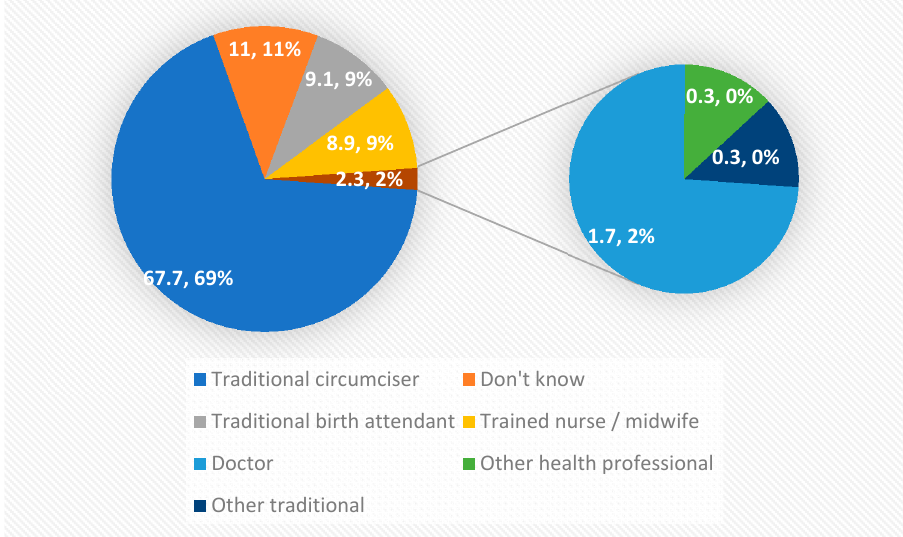
Figure 2. Type of health professional performing circumcision for respondent, Nigeria Demographic and Health Survey (NDHS).